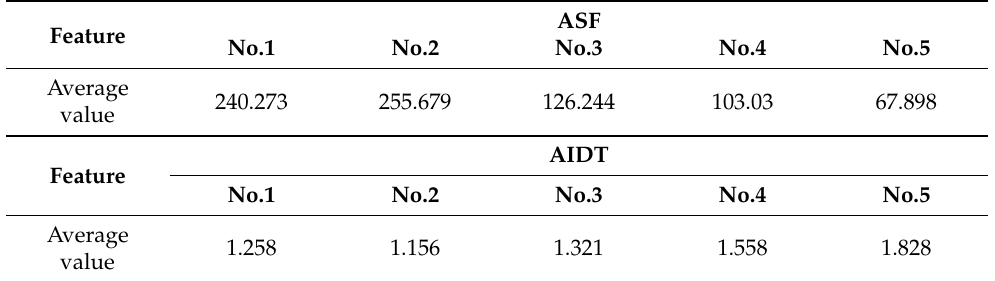
Table 4. Averages of the feature values.